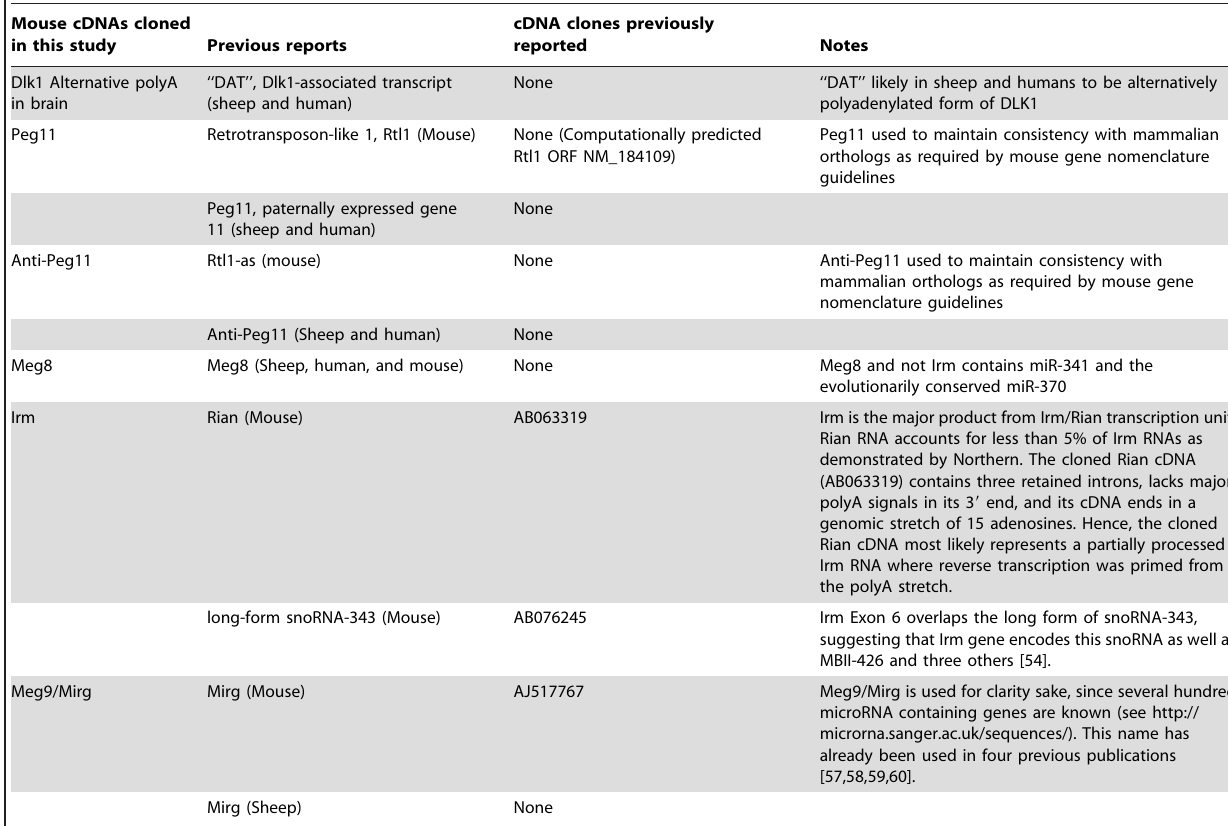
Table 3. Mouse cDNAs Cloned in This Study.